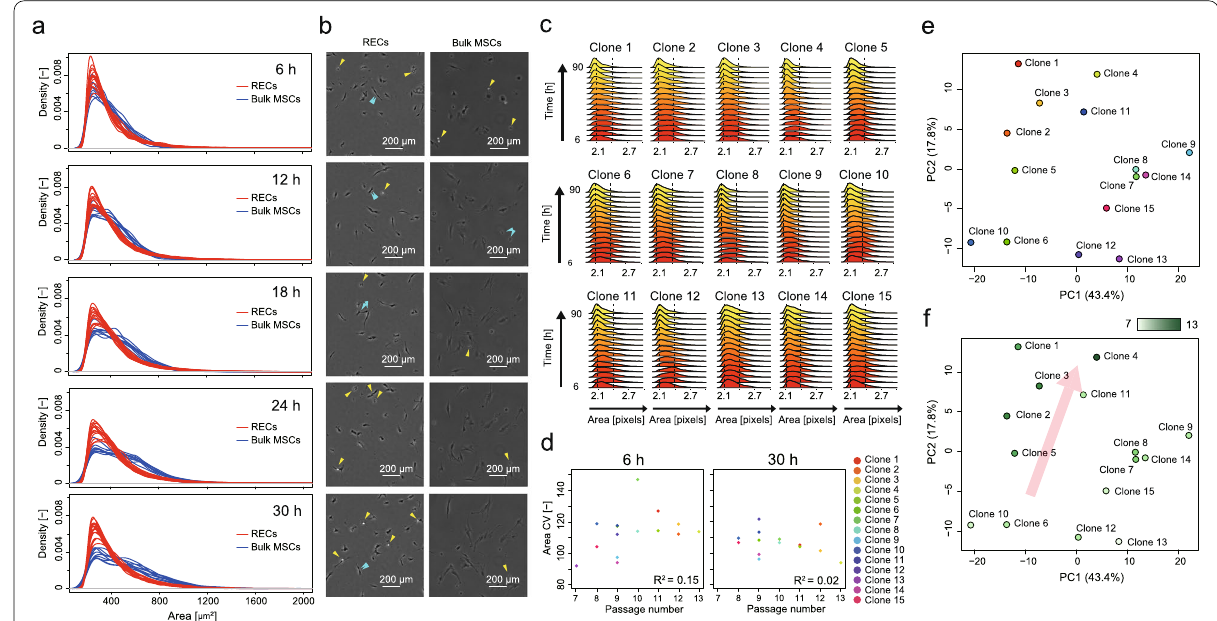
Fig. 3 Morphological characterization of 15 RECs. a Size distribution comparison between RECs (15 clones) and conventionally processed bulk MSCs (cMSCs, 9 lots) and their time-course changes. Only adherent and extending cells are counted. The dotted vertical line represents the average cell sizes. b Representative time-course images of REC and Bulk MSC. Yellow and blue arrows represent proliferating cells and proliferated cells in near time, respectively. c Size distribution and their time-course changes among 15 clones. d Correlation of “SD of area” and serial-passage limitation number. R 2 indicates the coefficient of determination. e , f PCA plot of 15 RECs profiled by 24 morphological descriptors. PCA plot with clone color labels ( e ). PCA plot colored by the heatmap of their serial-passage potencies ( f